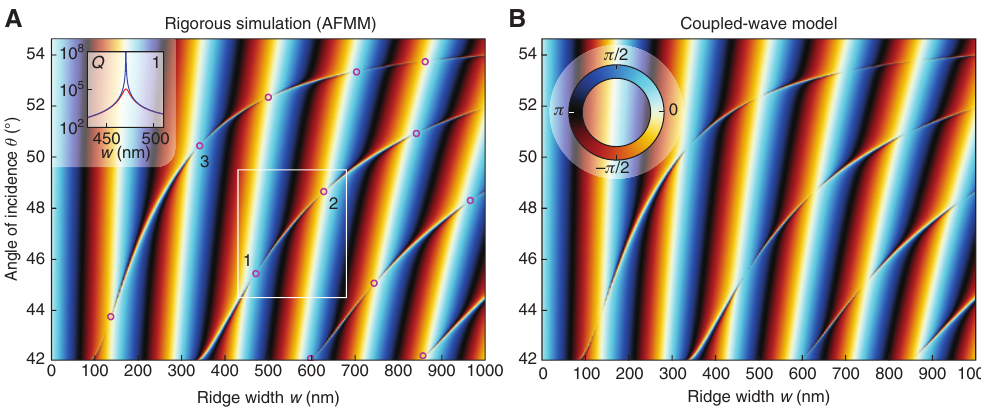
Figure 2: Phase of the reflected TE-polarized mode (arg R ) vs. ridge width w and angle of incidence θ calculated using (A) AFMM and (B) the proposed coupled-wave model. Magenta circles show the BIC positions predicted using the coupled-wave model. The inset in (A) shows the quality factor of the resonance near the BIC marked with “1” (blue line); red line illustrates the decrease in the Q factor in the case when a small imaginary part ( k = 10 −5 ) is added to the refractive index of the waveguide. The BICs “1” and “2” bounded by the white rectangle are investigated in detail in Section